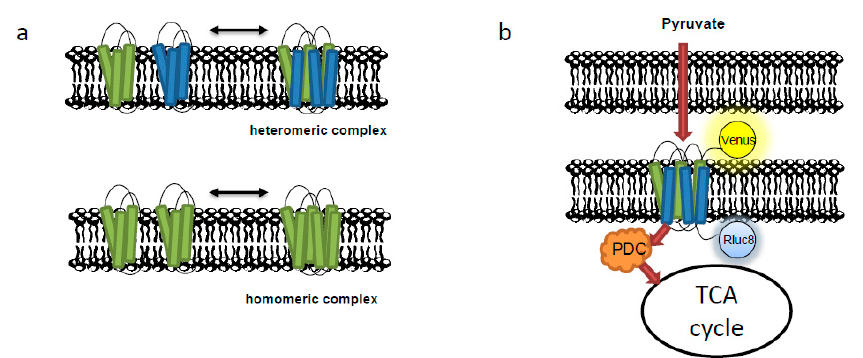
Figure 1. Protein complex of the mitochondrial carriers. ( a ) The association of both homodimers and heterodimers of the mitochondria carrier may result in the active transporter. ( b ) Monitoring the heterodimer of the pyruvate carrier by the bioluminescence resonance energy transfer (BRET).